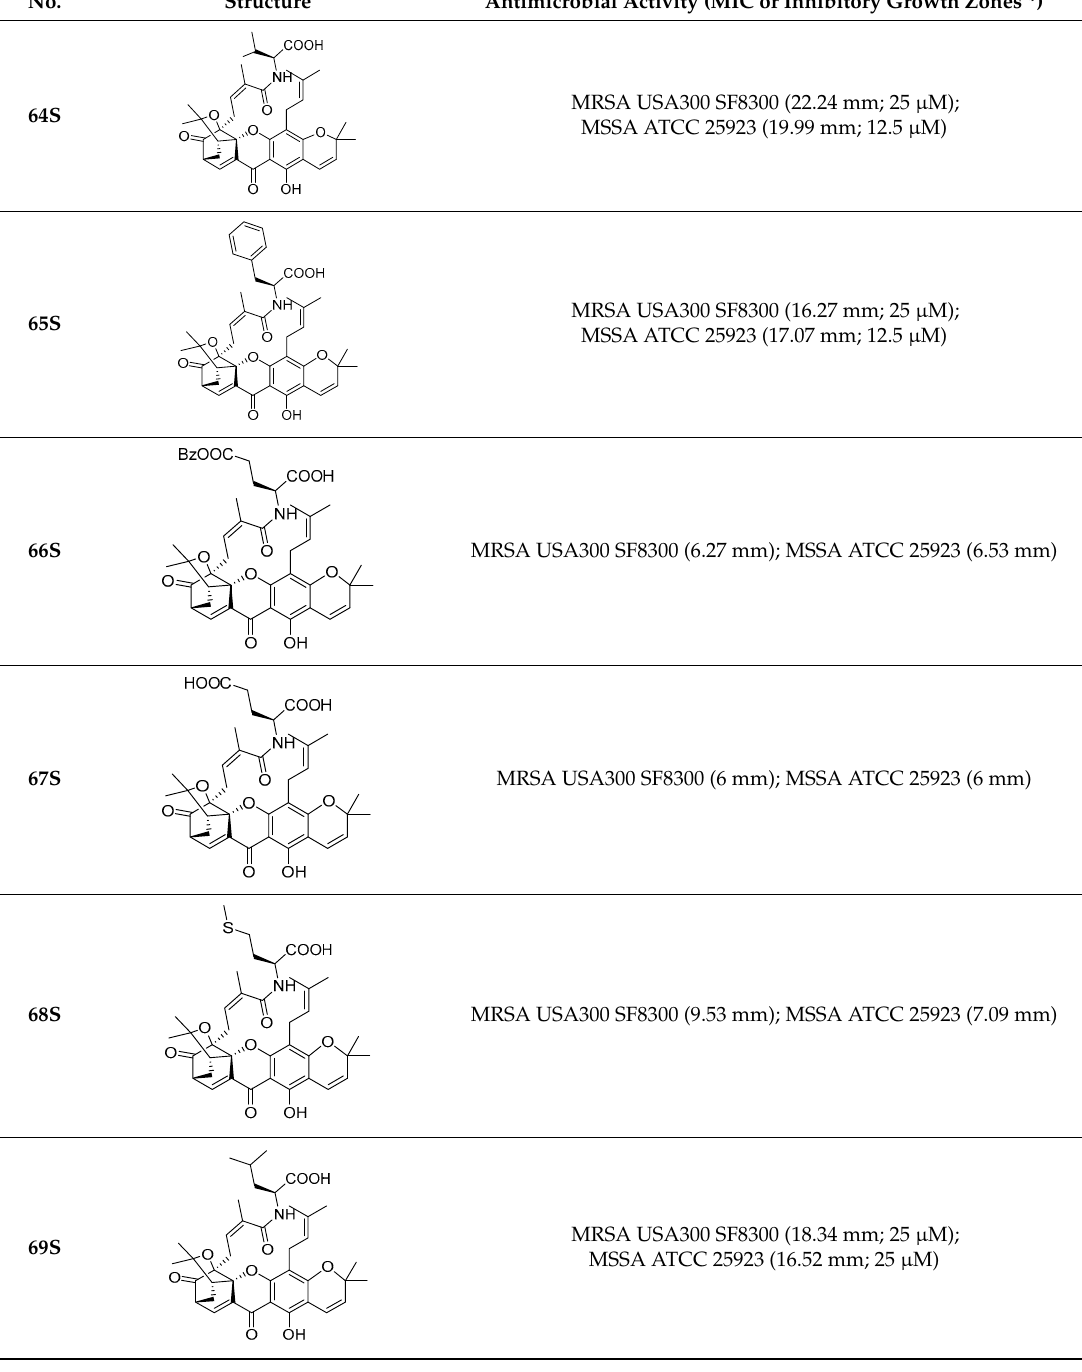
Table 12. Antimicrobial activity of derivatives of caged xanthones.